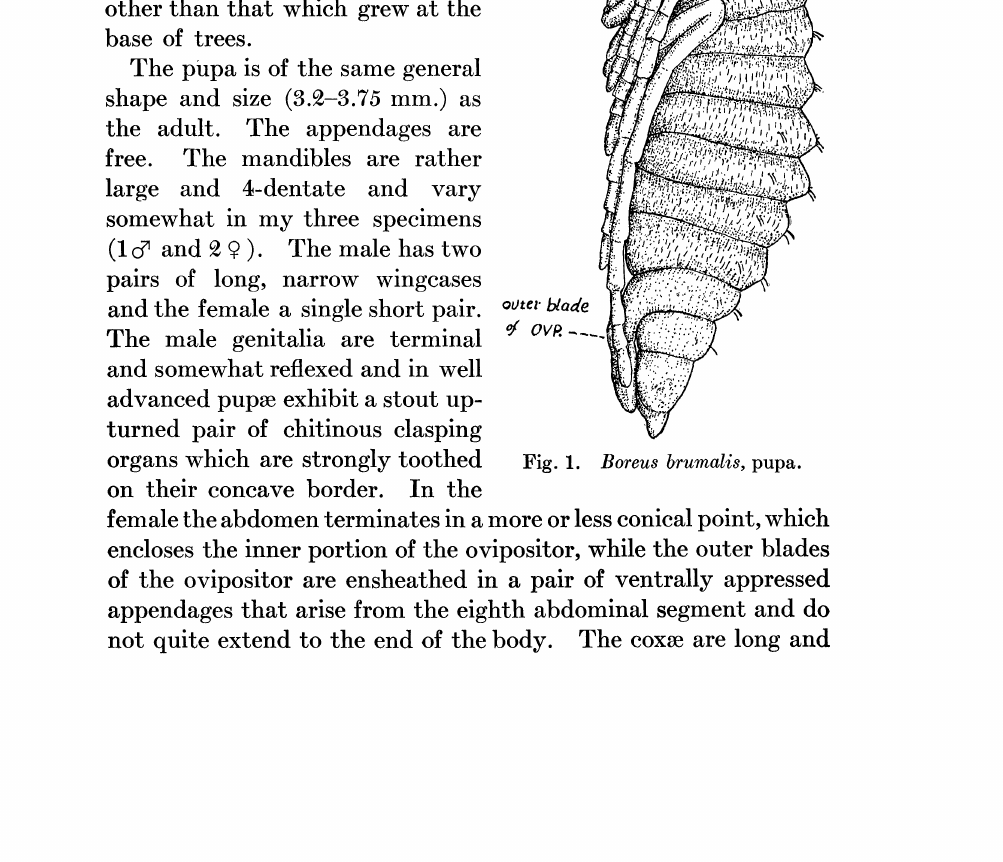
on their concave